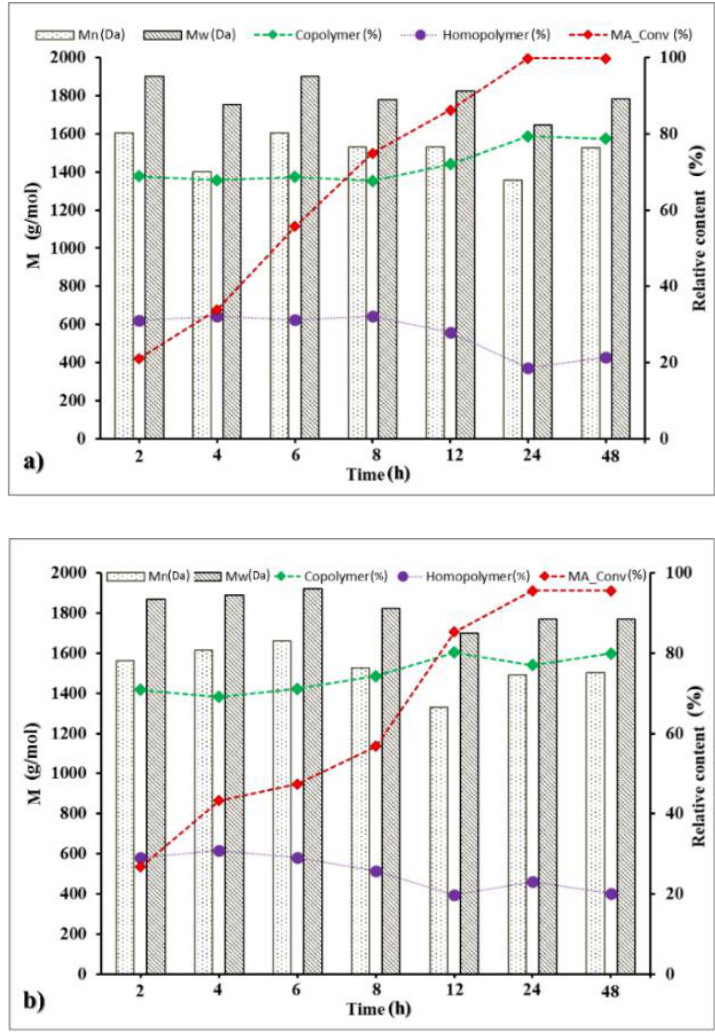
Figure 3. Time course of the oligoester synthesis reaction catalyzed by Novozyme 435 ( a ) and GF-CalB-IM ( b ). Reaction parameters: ECL:MA molar ratio 2:1 in a solventless system at 80 °C.